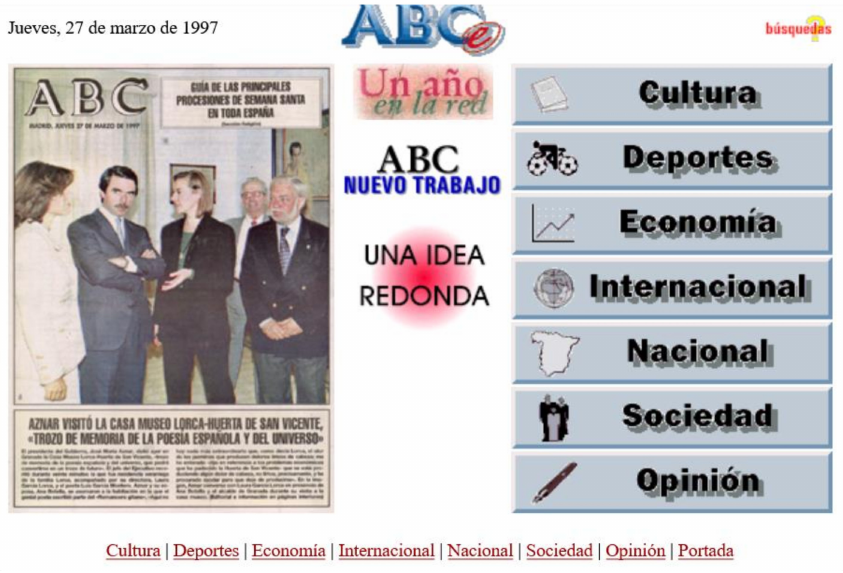
Figure 1. Print-publication dumping in early abc.es online edition (27 March 1997). Compiled by the